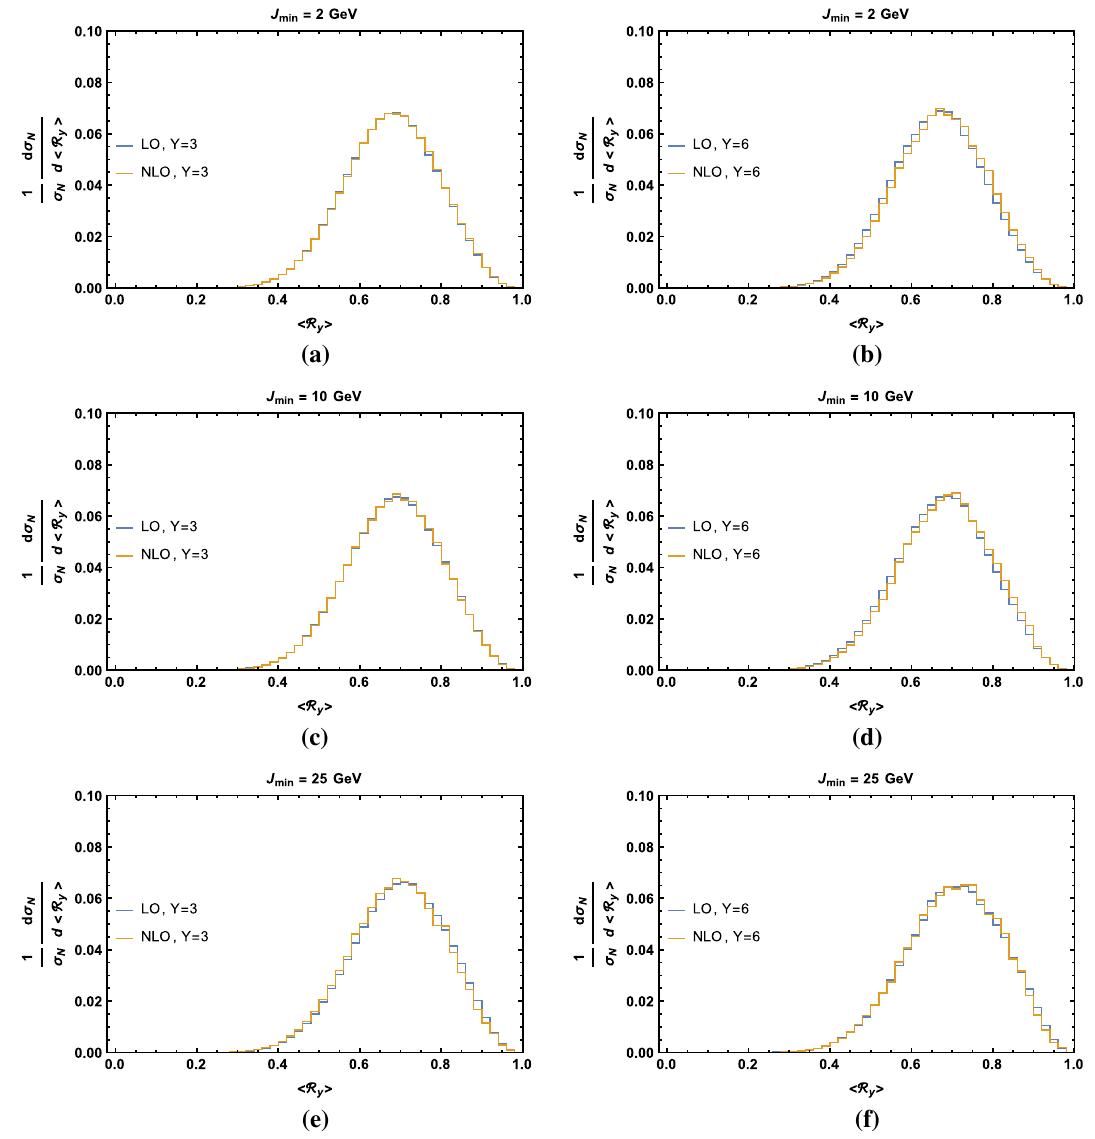
Fig. 10 Comparison of LO and NLO+DLs normalized (cid:10) R y (cid:11) distributions for multiplicity N = 5, rapidity differences Y = 3 (left) and Y = 6 (right) and J min = 2 (top), J min = 10 (middle), J min = 25